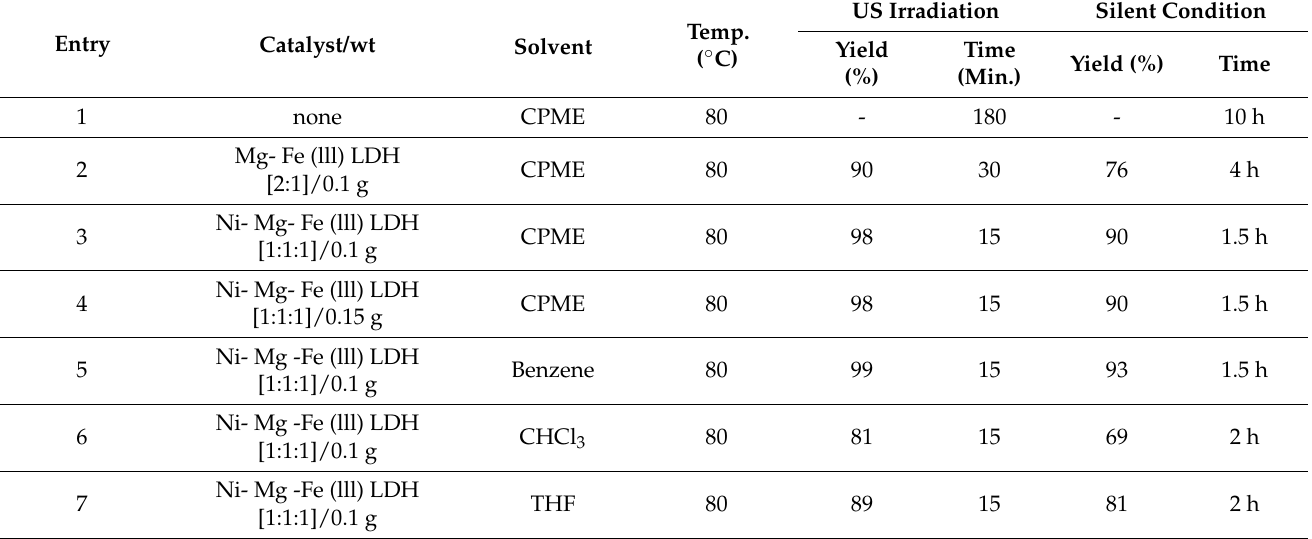
Scheme 1. Optimization of the reaction conditions for the 1,3-dipolar cycloaddition reaction. Table 3. Screening of the reaction conditions for the synthesis of Table 3. Screening of the reaction conditions for the synthesis of pyrazoles.